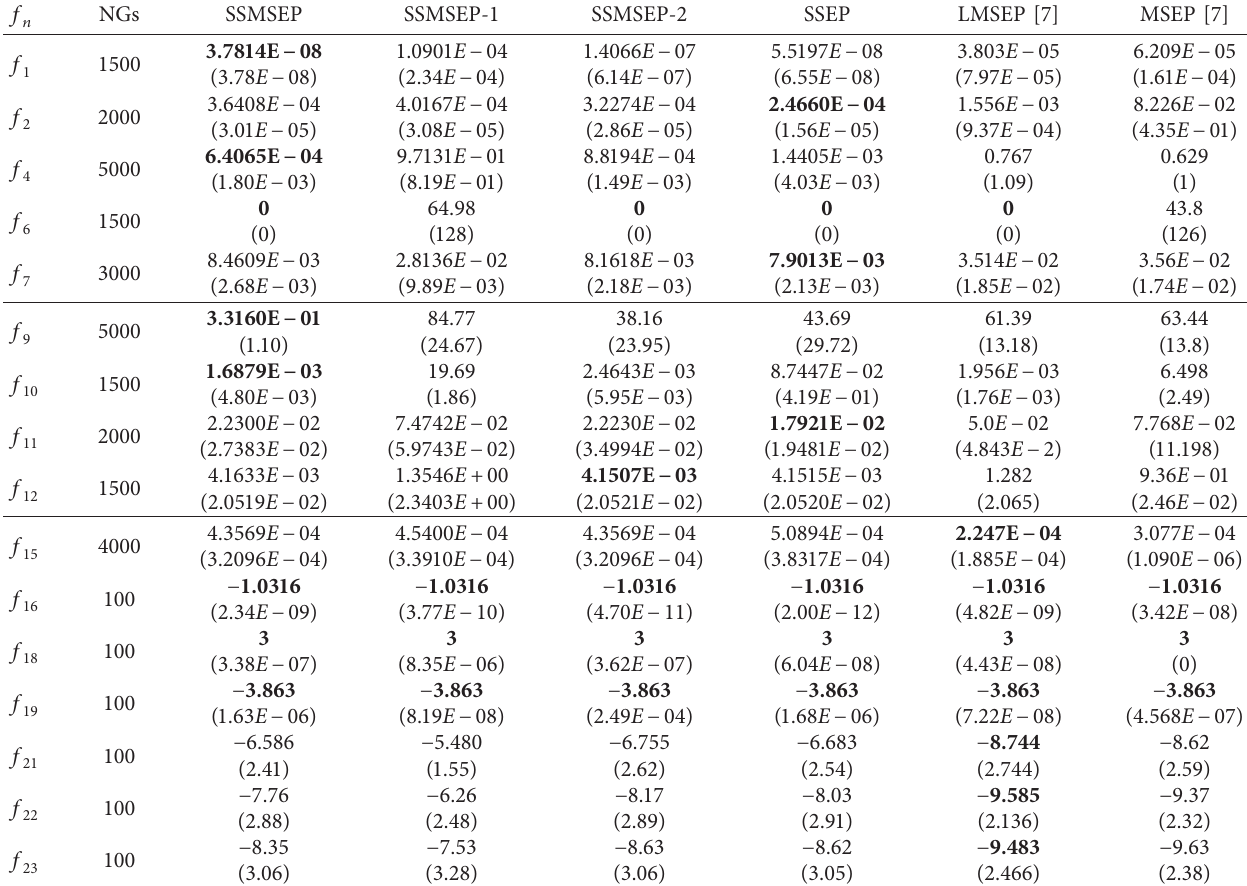
Table 7: Mean and standard deviations of SSMSEP, SSMSEP-1, SSMSEP-2, SSEP, MSEP, and LMSEP ( f f − f averaged over 1000 runs; the mean best fitness values are shown in 16 23